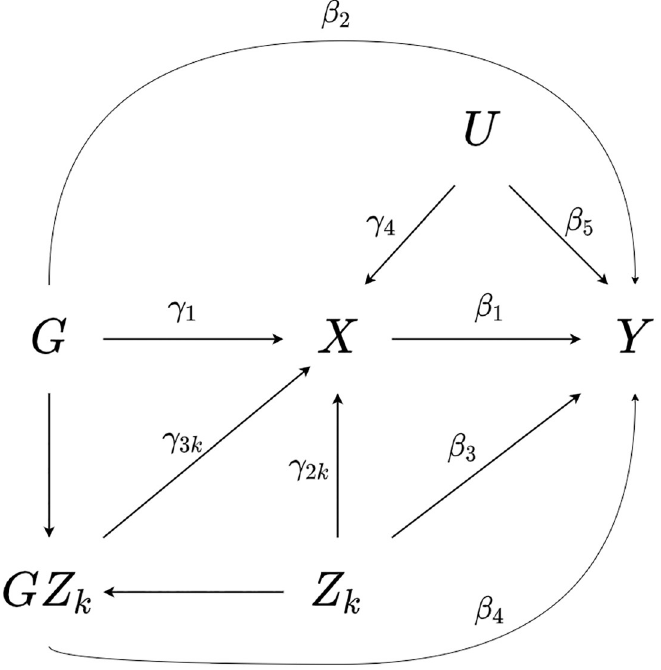
Fig 1. Illustration of data generating model. A directed acyclic graph showing the relationship between a genetic , exposure X , outcome Y , and one or more confounders U . GZ instrument G , an interaction covariate Z k interaction G × Z k , and G , Z k , and U are assumed